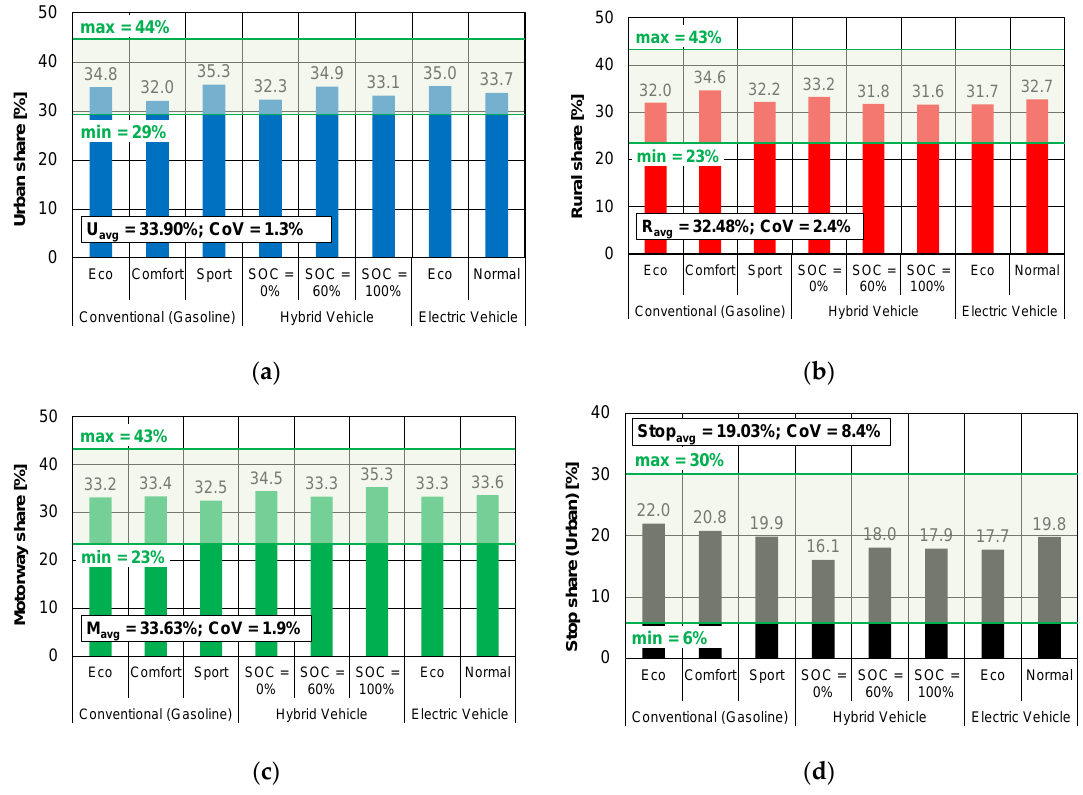
Figure 6. Comparison of selected parameters of the road tests obtained and required for the following data: ( a ) share of the urban phase in the RDE test, ( b ) share of the rural phase in the RDE test, ( c ) share